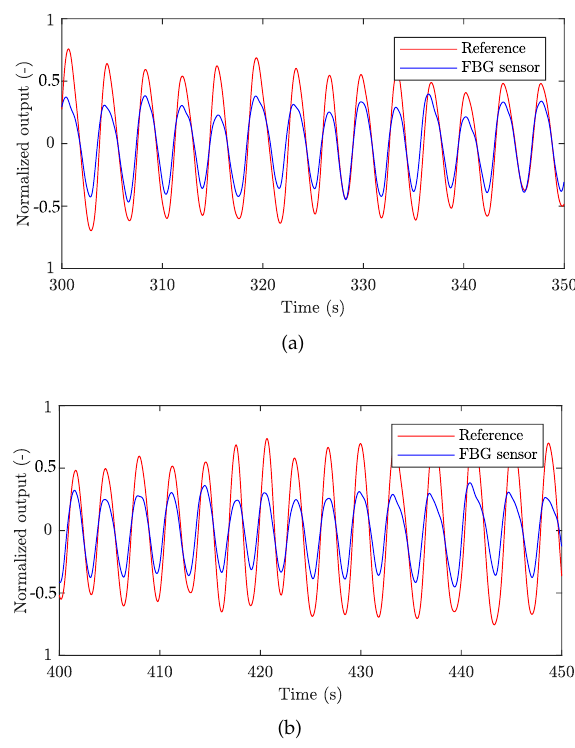
Figure 10. A sample recording of breathing activity using the FBG and the reference device: ( a ) M1 volunteer, and ( b ) F1